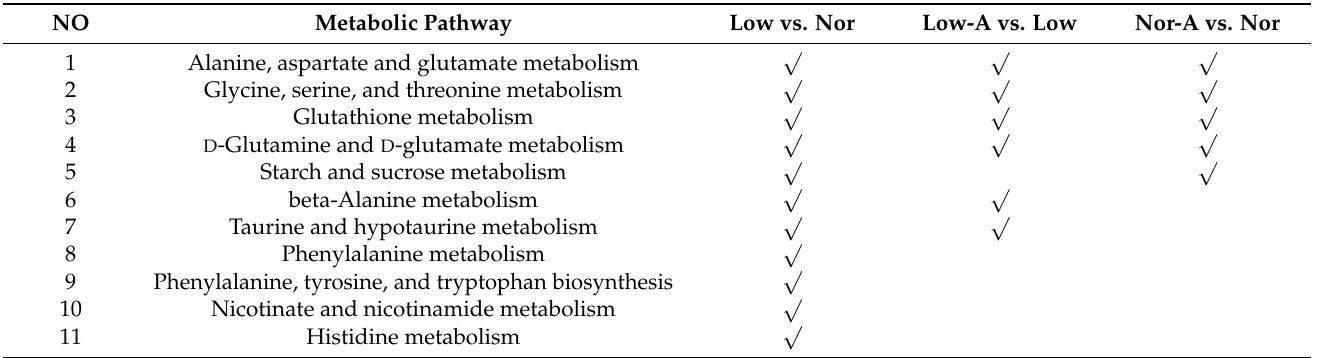
Table 2. Significantly altered metabolic pathways identified from the pairwise comparisons between the Nor-A and Nor groups, the Low and Nor groups, the Low-A and Low groups. NO Metabolic Pathway Low vs. Nor Low-A vs. Low Nor-A vs. Nor 1 Alanine, aspartate and glutamate metabolism